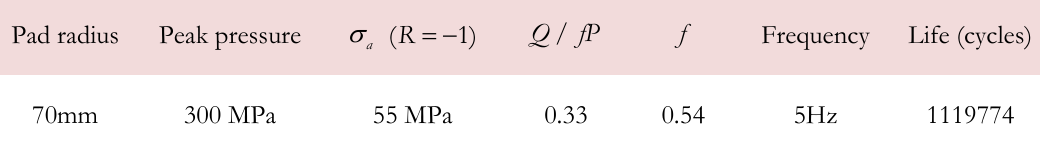
Table 2: Parameters and observed life of the fretting fatigue test used to design an equivalent notch fatigue test. Minimization of the difference between the two gradients was achieved by using a 0.5mm notch radius specimen, with